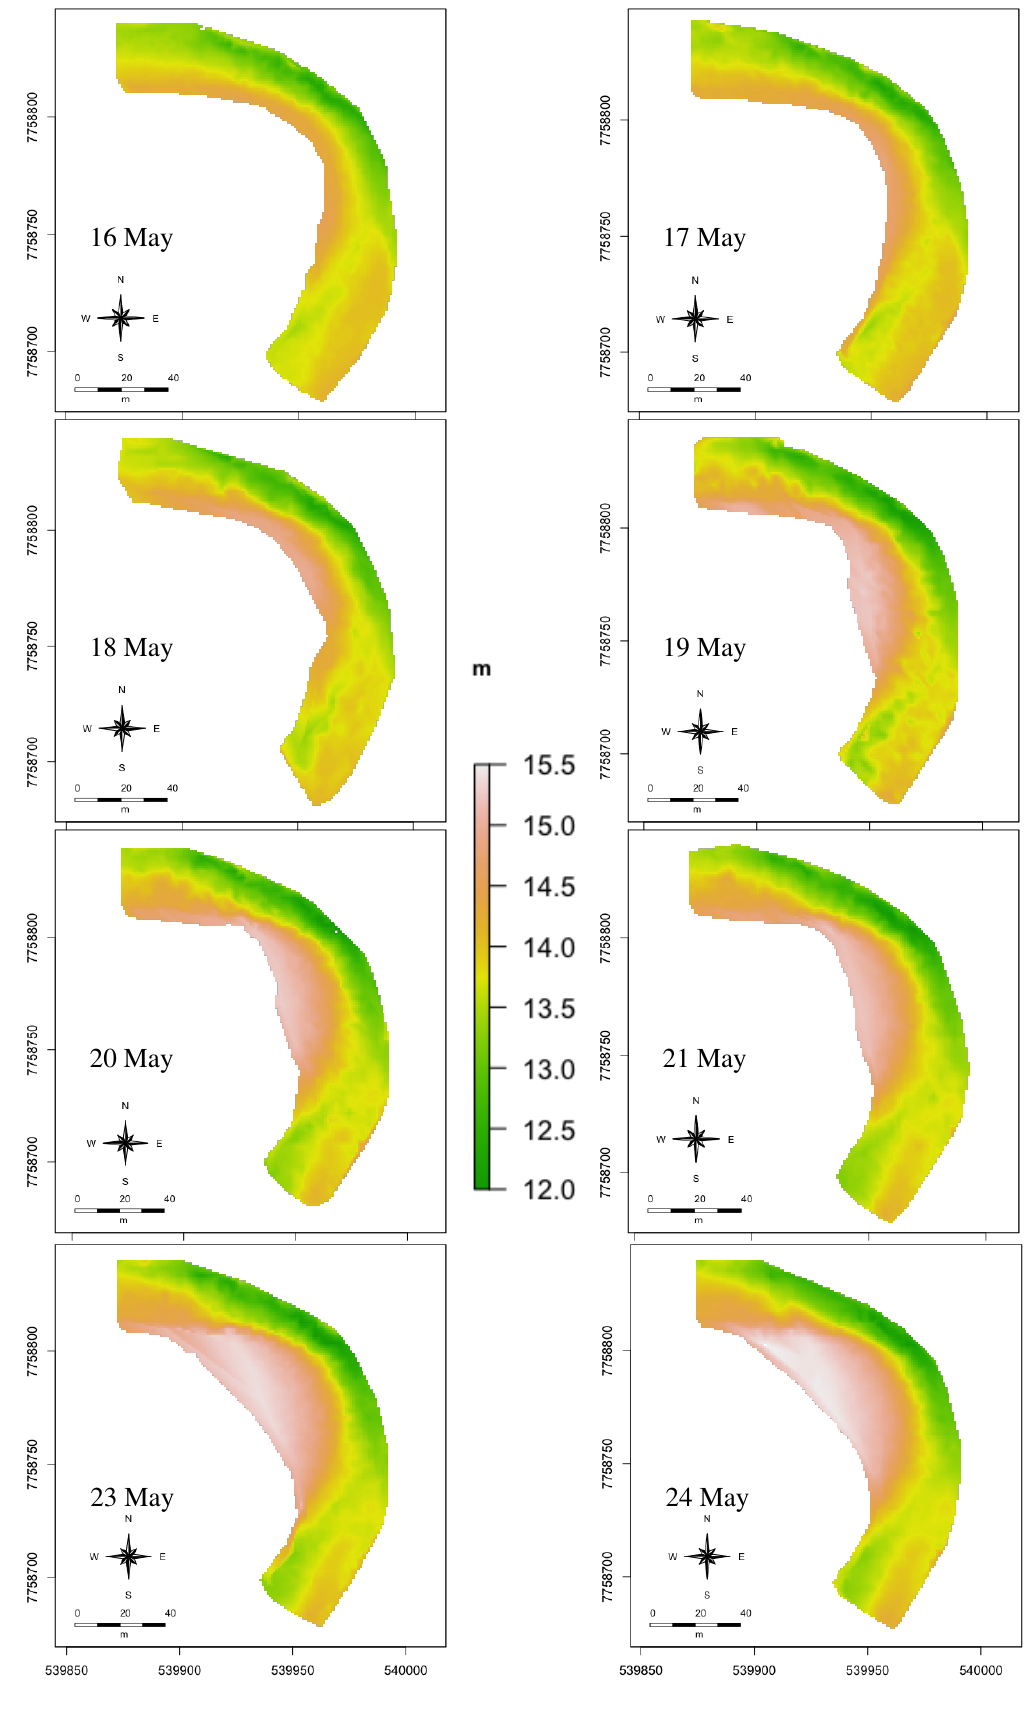
Figure 12. River bathymetry. Bed topography is shown as elevation in meters above sea